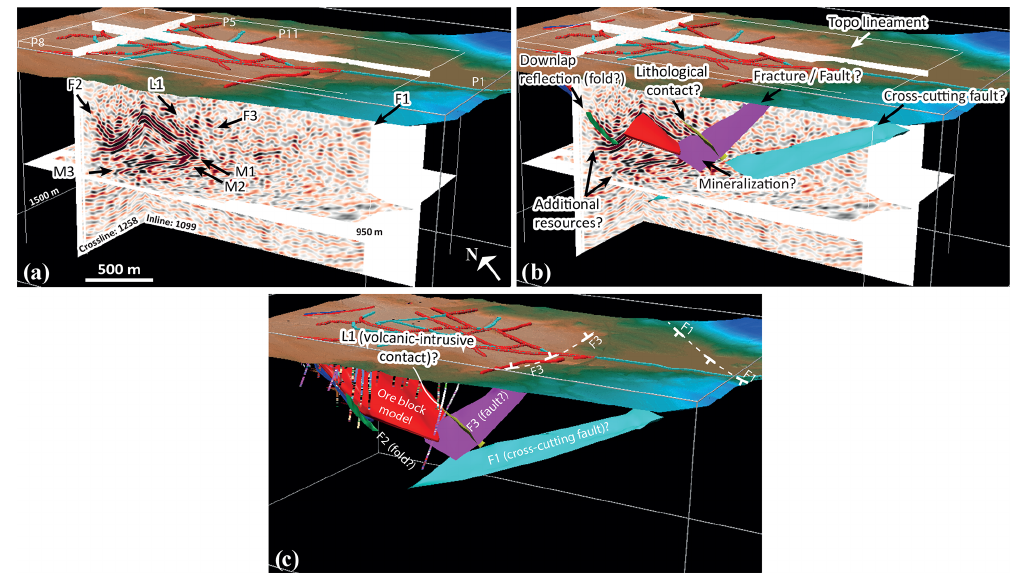
Figure 12. The 3D views from the migrated and time-to-depth-converted stacked volume showing (a) a series of strong southeast-dipping reflections (e.g. M1 and M2) and a number of northwest-dipping ones (e.g. F1 and F2), as well as how (b) they have been picked to represent various surfaces within the volume. The red surface is the ore block model derived from borehole data. (c) F1–F3 are interpreted to be either from fault and fracture systems or from folds. Note also that F1 and F3 may be correlated with the topographic lineaments observed on the lidar data. Reflection L1 is interpreted to be from the contact between volcanic and intrusive